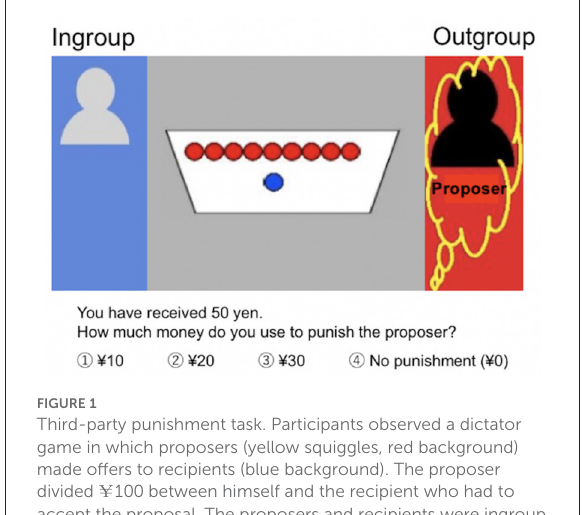
FIGURE1 Third-party punishment task. Participants observed a dictator game in which proposers (yellow squiggles, red background) made offers to recipients (blue background). The proposer divided U 100 between himself and the recipient who had to accept the proposal. The proposers and recipients were ingroup (gray) or outgroup (black) members. In this Figure, the amounts allocated to the proposer (outgroup) were U 90 and U 10 were allocated to the recipient (ingroup). At the beginning of each trial, participants received an endowment of U 50 and were instructed to choose an amount [between U 0 and U 30 (in increments of U 10)] to punish the proposers. Assigning U 10 costs the participant U 10 and the sanctioned proposer U